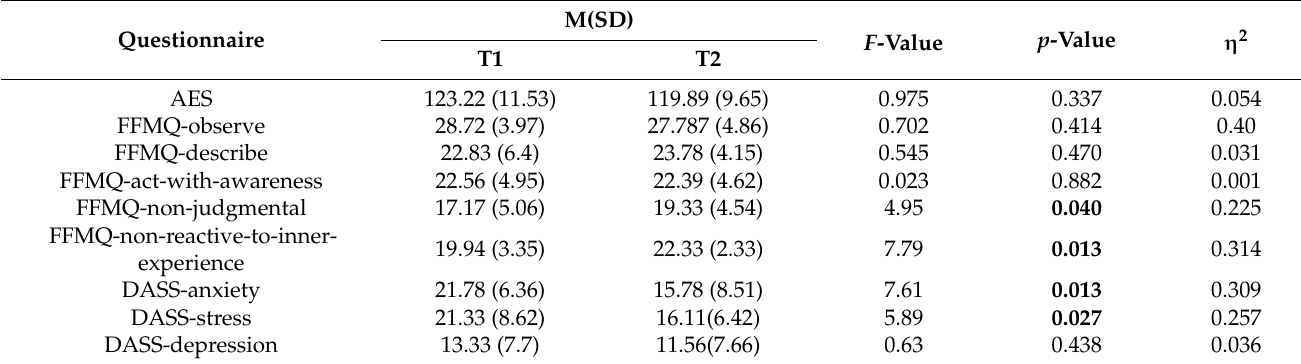
Table 2. Statistical comparison of results of pre- (T1) and post-intervention (T2) for AES, FFMQ, and DASS pre-experimental questionnaires.